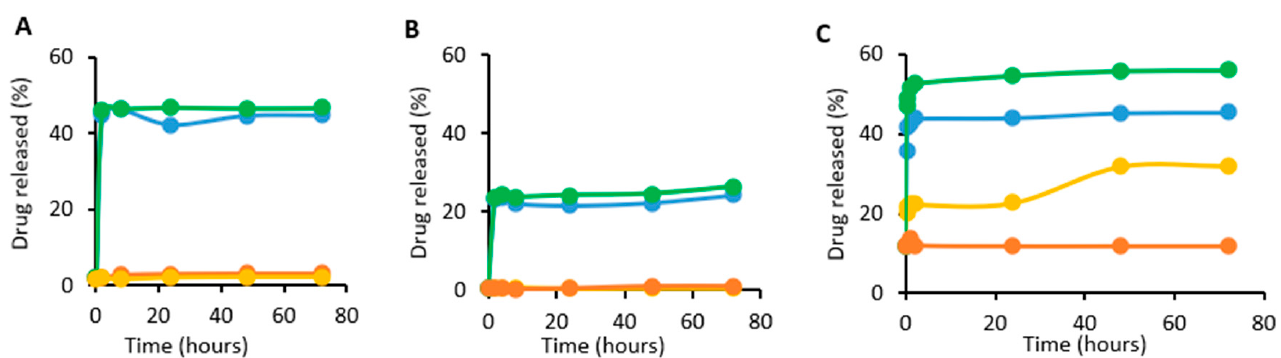
Figure 4. Release of Dox from ABNs with EDC ( A ), Glutaraldehyde ( B ), and SPDP ( C ) at different time points. The conditions tested were pH 5 (blue), GSH 1 mM (yellow), pH 5 and GSH 1 mM (green), and pH 7 with GSH 1 µM (orange).